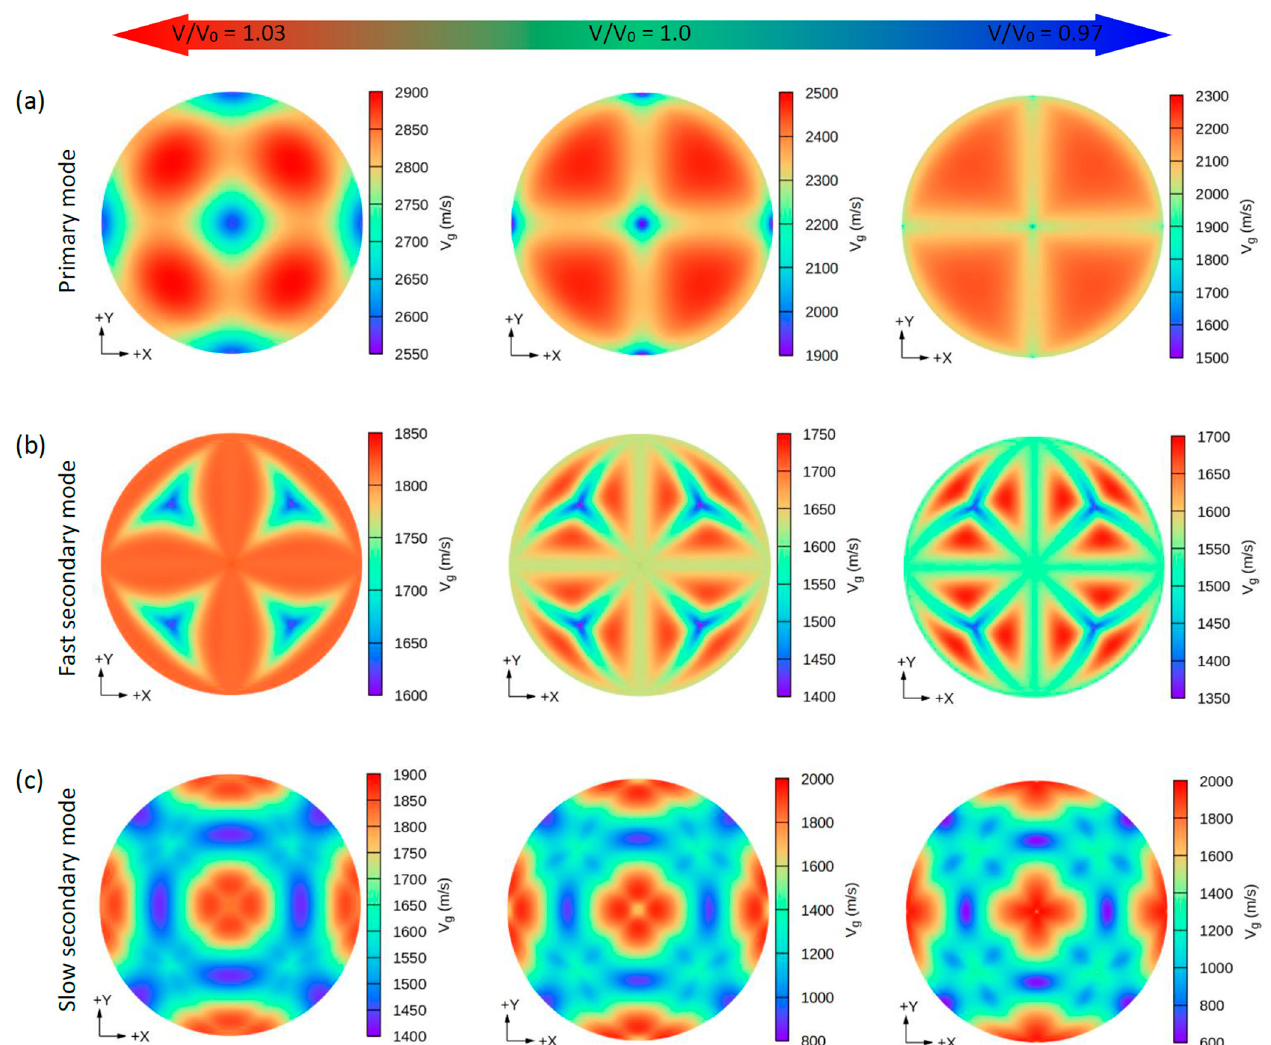
Figure 7. The calculated 2D directional dependence of the group wave velocity (V g ) in (xy)/(001-plane for CsK 2 Bi. There are two types of acoustic wave velocities, i.e., the longitudinal wave velocity and the transverse wave velocities in two directions. The single primary mode ( a ) is the longitudinal wave velocity and the two secondary modes, namely, fast secondary ( b ) and slow secondary ( c ), correspond to the transverse wave velocities. Table 2. The minimum (max) and the maximum (min) values of primary mode (P), fast secondary (FS), and slow second- ary (SS) of the phase and group velocity, Young’s modulus (E), Poisson’s ratio ( ν ), and anisotropic indexes A U and A Z of Cs(Na, K) 2 Bi under hydrostatic compression (V/V 0 = 0.97), hydrostatic tension (V/V 0 = 1.03), and equilibrium state (V/V 0 = 1.0).